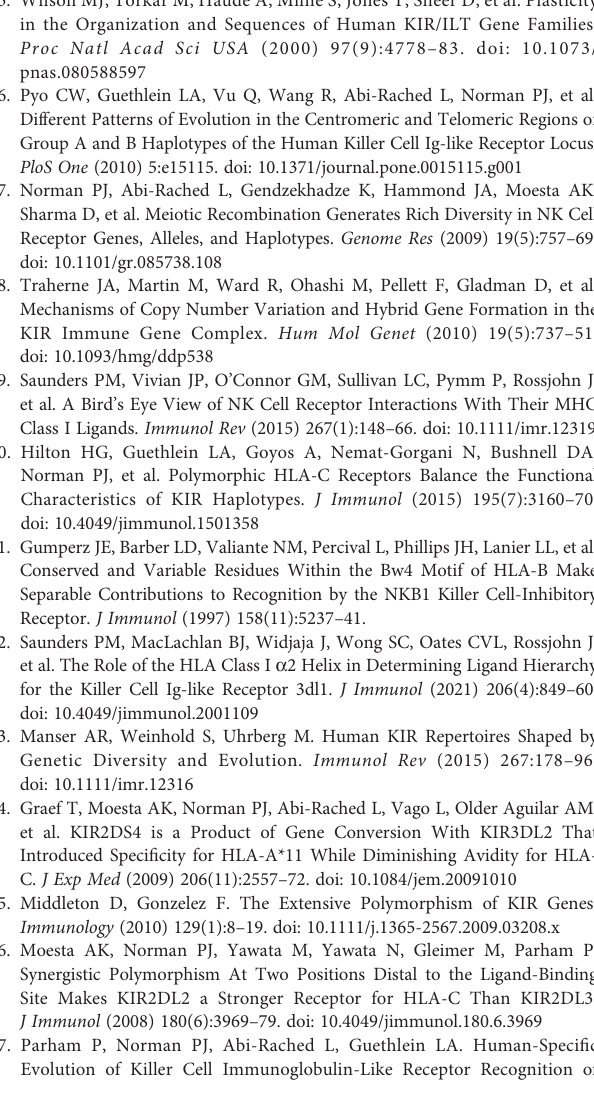
KIR B haplotypes shaded blue.